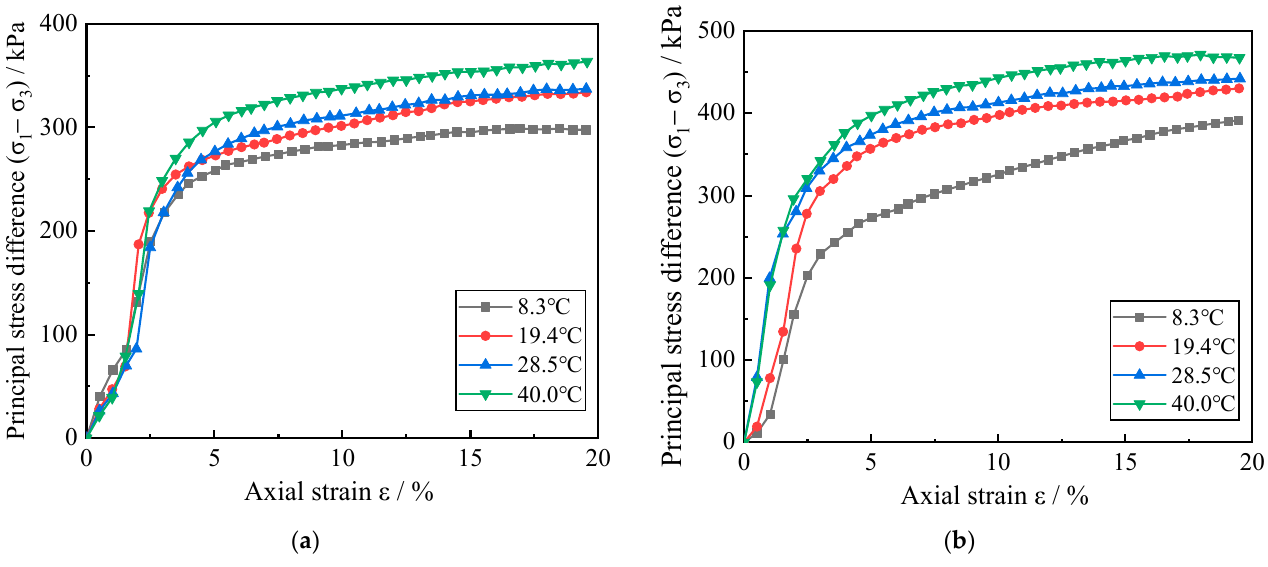
Figure 2. Stress–strain curves of red clay under different temperature conditions. ( a ) The zinc ion concentration is 0% and the confining pressure is 300 kPa; ( b ) The zinc ion concentration is 0.5% and the confining pressure is 400 kPa.